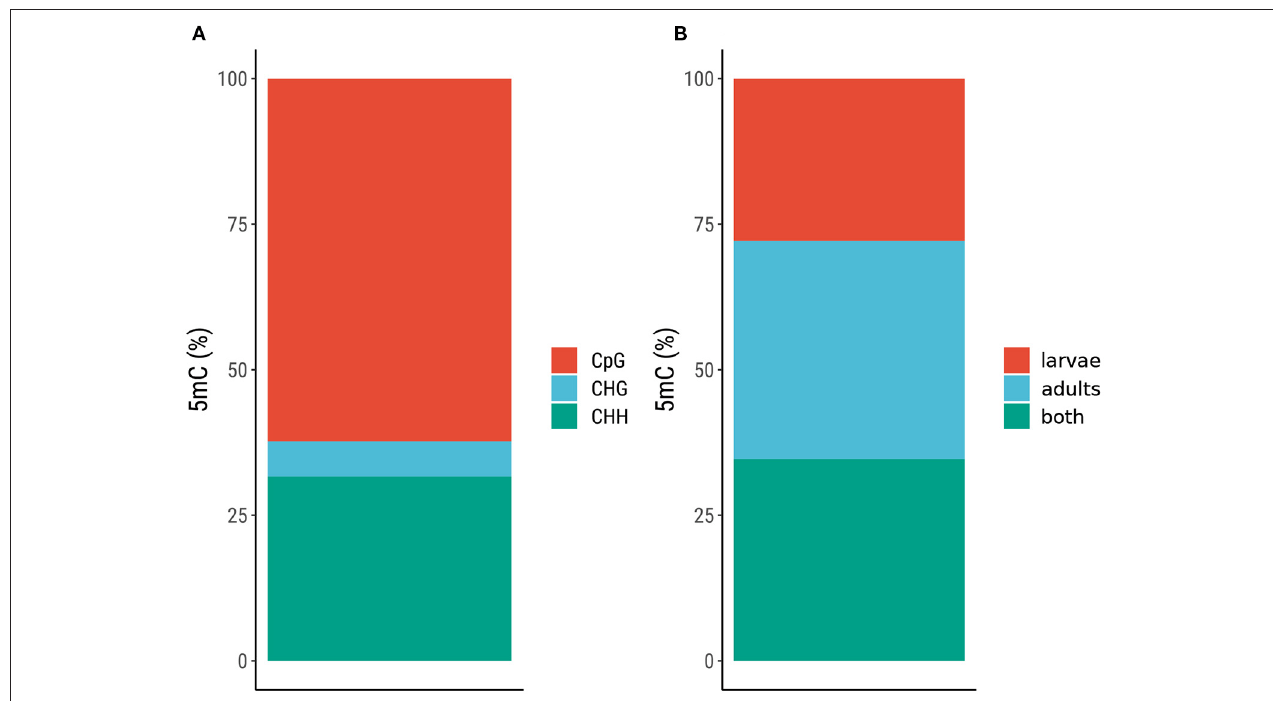
FIGURE 2 | CpG O/E analysis of Manduca sexta showing a unimodal distribution, which represents a low rate of C to T transitions in the sequence context CpG and therefore indicates a generally low level of CpG methylation.